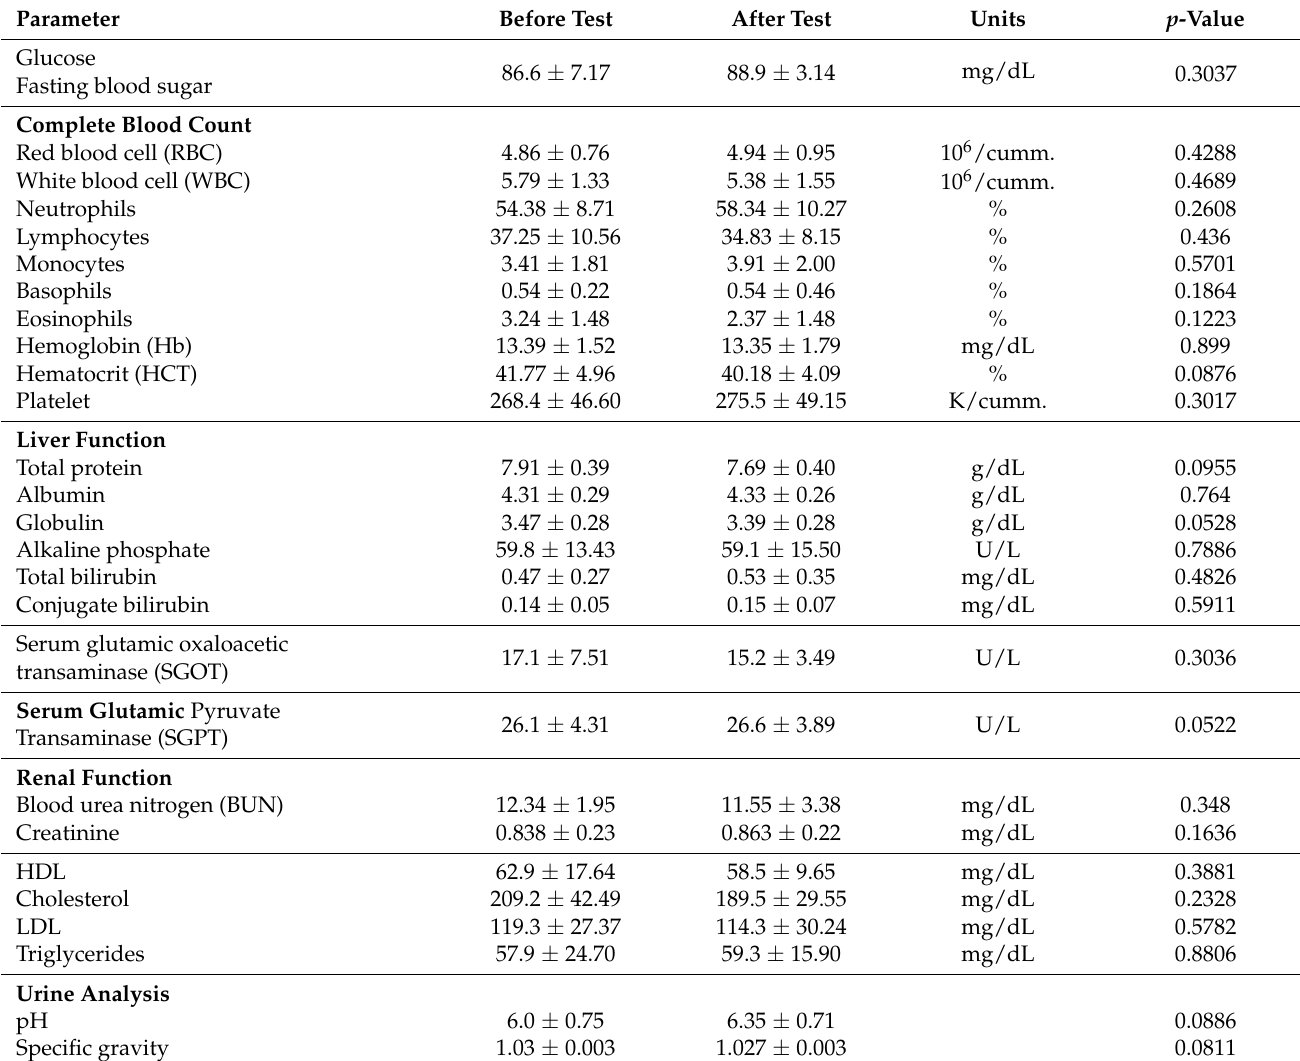
Table 5. The laboratory results of healthy volunteers prior to and after treatment with three types of